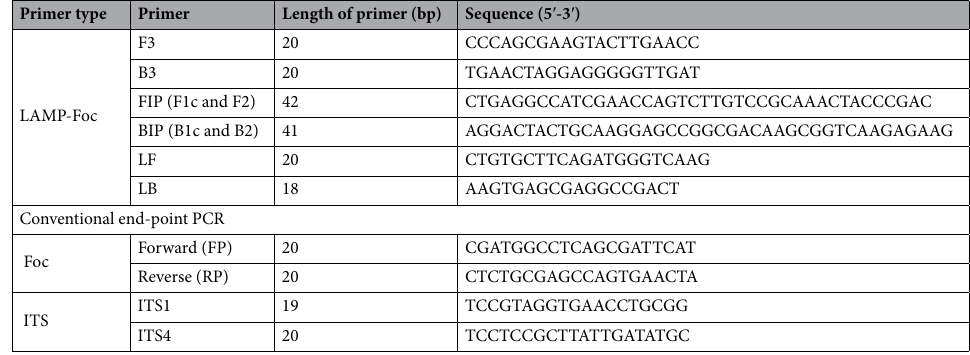
Table 1. Details of the primers designed based on the putative effector gene found to be unique to Fusarium oxysporum f. sp. ciceris